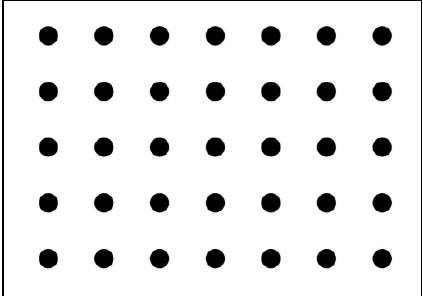
Figure 11. Grid of circles printed and used for the camera calibration.